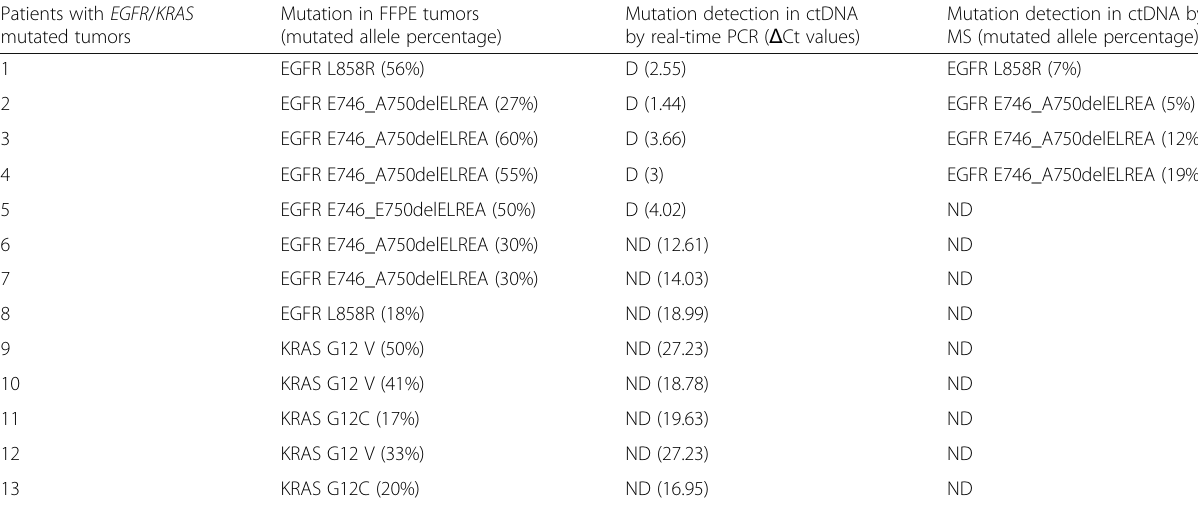
Table 5 Mutation detection in ctDNA by real-time PCR and MS approaches Patients with EGFR / KRAS mutated tumors